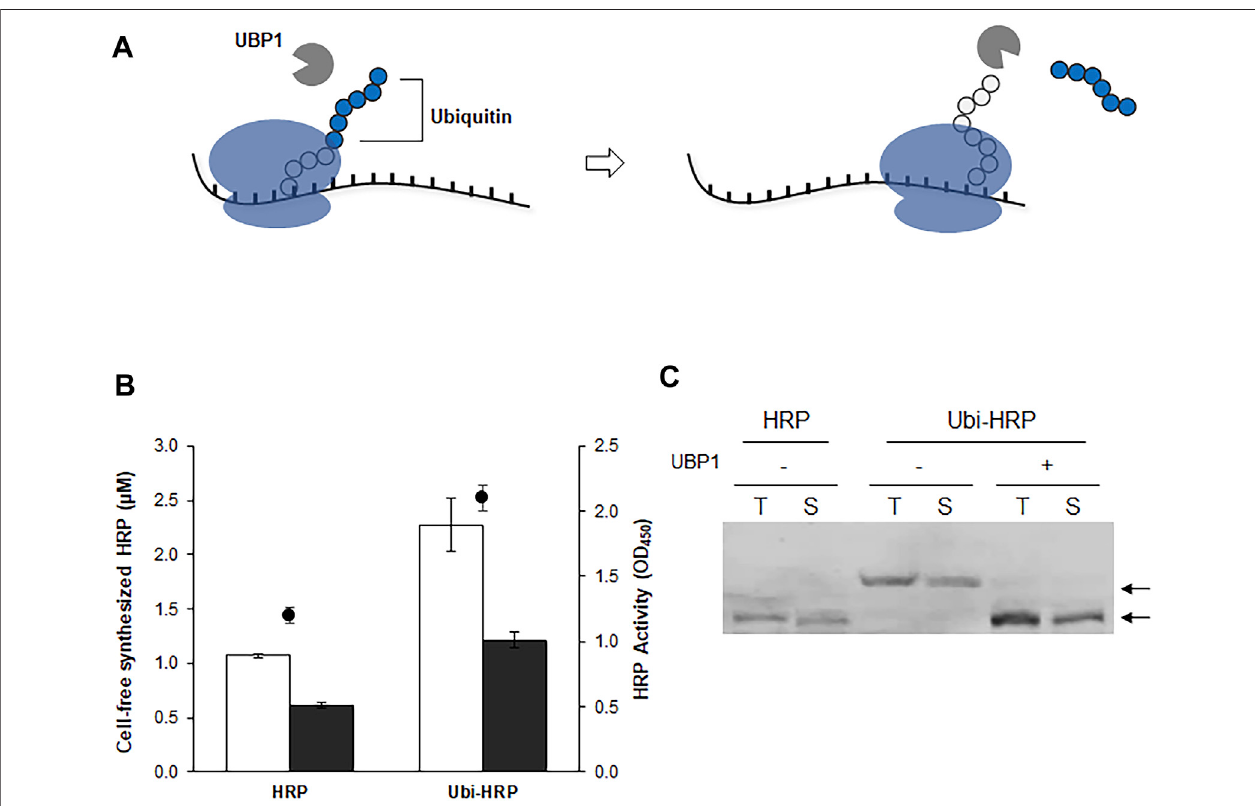
FIGURE3| Enhanced translationand insitu cleavage ofubiquitin-tagged HRP. (A) The template DNAisfused withaubiquitin sequence, which enhances thecell- freeproduction ofHRP.Due tothepresenceofUBP1inthecell extract, theubiquitin sequenceiscleaved off thetranslation product, enablingthesynthesis ofHRPinits native amino acid sequence. (B) Total yields (blank bars), soluble yields ( fi lled bars), and enzyme activity (circles) of the cell-free synthesized HRP. (C) Western blot analysis of cell-free synthesized HRP. Arrows indicate the molecular weights of HRP in the presence (Ubi-HRP) or absence (HRP) of the N-terminal ubiquitin